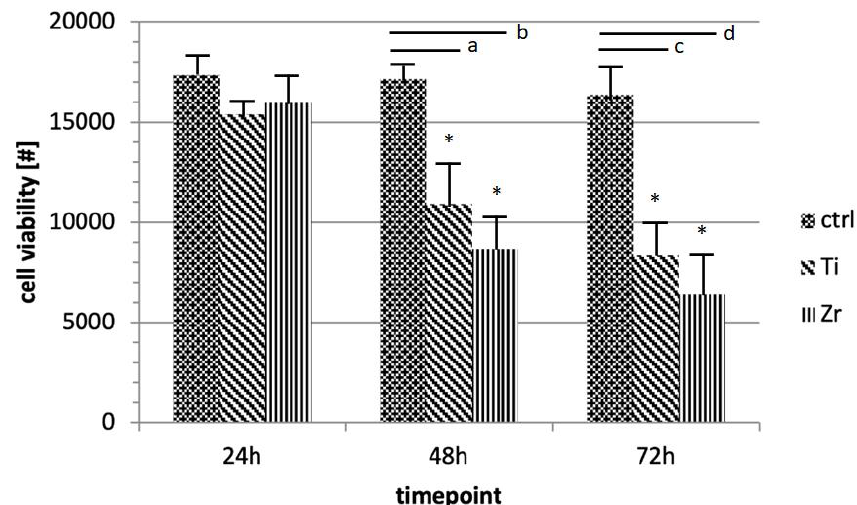
Figure 4. Trypan blue assay. The graph represents cell viability of the specimens (T1, T2, and C) at different time points (24, 48, and 72 h). Values are expressed as mean ± standard deviation (* p < 0.05): (a) Ti versus control, 48 h, p < 0.018; (b) Zr versus control, 48 h, p < 0.002; (c), Ti versus control, 72 h, p < 0.005; (d) Zr versus ctrl, 72 h, p < 0.001.